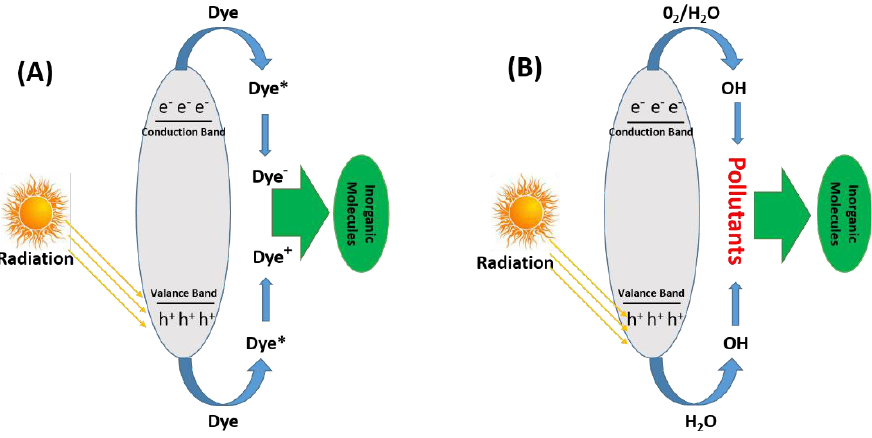
Figure 9. Dye photo-degradation through sensitization route ( A ); mechanism of photocatalytic treatment of pollutants ( B ) (Dye* for unstable dye)